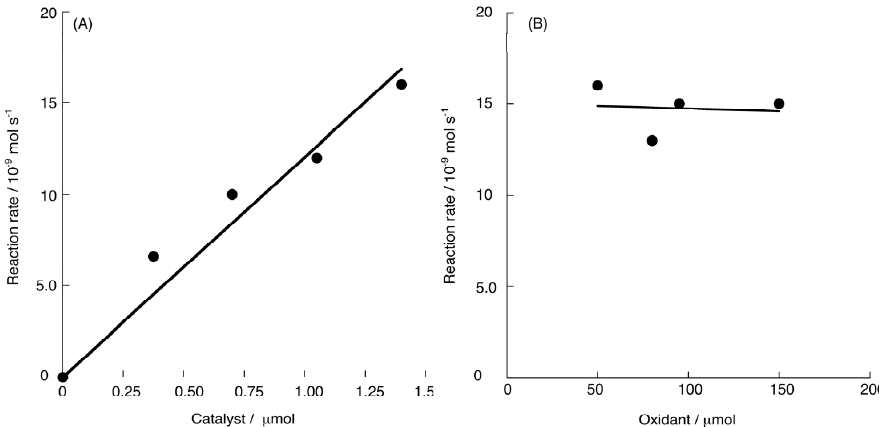
Figure 3. Plots of initial reaction rates for oxygen evolution with [ 3 ](BF 4 ) 3 : ( A ) as a function of amounts of [ 3 ](BF 4 ) 3 (µmol) in 5.0 mL of pH 1.0 water (adjusted by HNO 3 ) containing (NH 4 ) 2 [Ce(NO 3 ) 6 ] (50 µmol ) at 293 K; and ( B ) as a function of amounts of oxidant ((NH 4 ) 2 [Ce(NO 3 ) 6 ]) in the presence of [ 3 ](BF 4 ) 3 (1.4 µmol) in 5.0 mL of pH 1.0 water (adjusted by HNO 3 ) at 293 K.